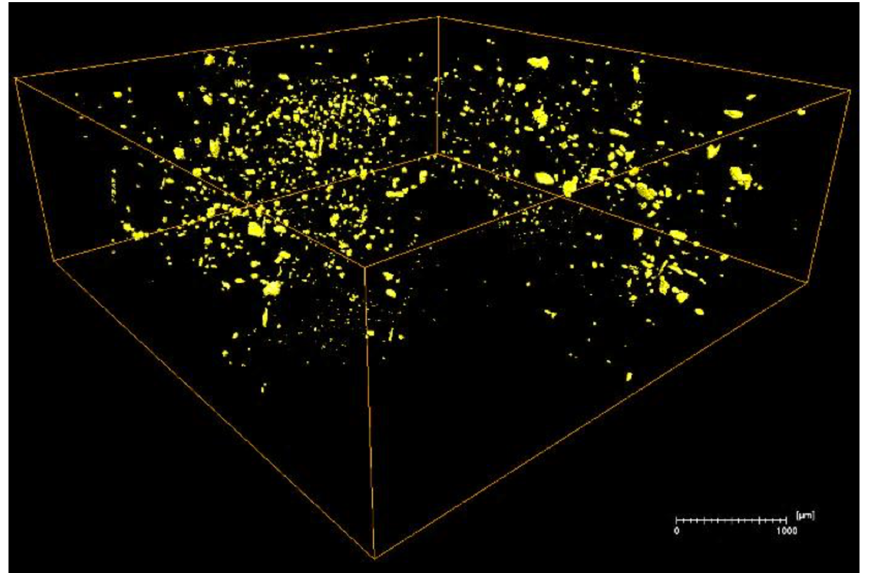
Figure 17. The HRXCT images show that the metallic inclusions distribute relatively uniformly and take up 0.07% volume of the host.